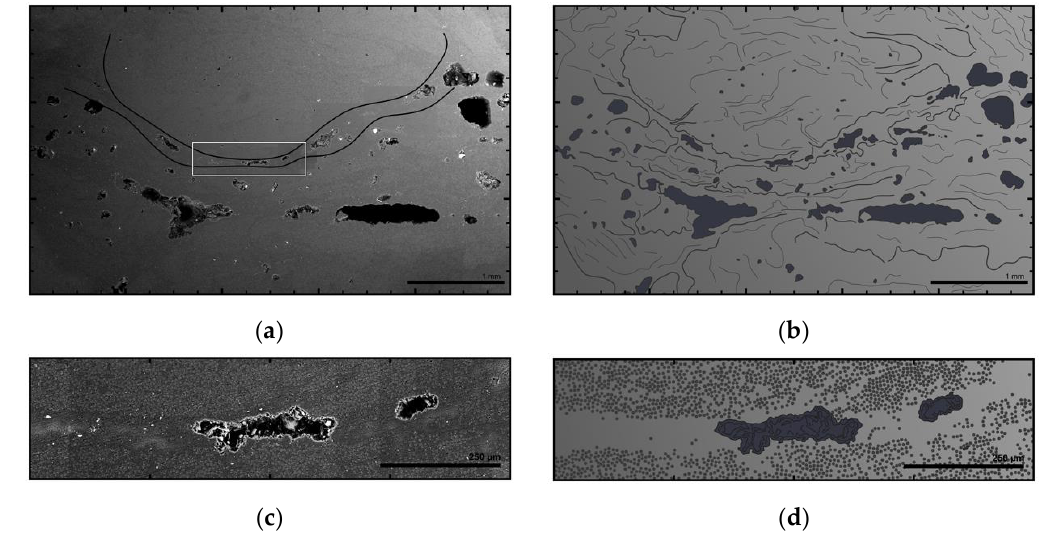
Figure 9. SEM scan of the fiber bundle interface area cross-section: ( a ) SEM scan from Figure 8 with indication of the interfaces between rovings; ( b ) schematic analysis of the same area, with voids and inner roving structures marked; ( c ) enlargement of the framed area in subfigure a; ( d ) schematic analysis of subfigure a with marked voids and single carbon fiber filaments.